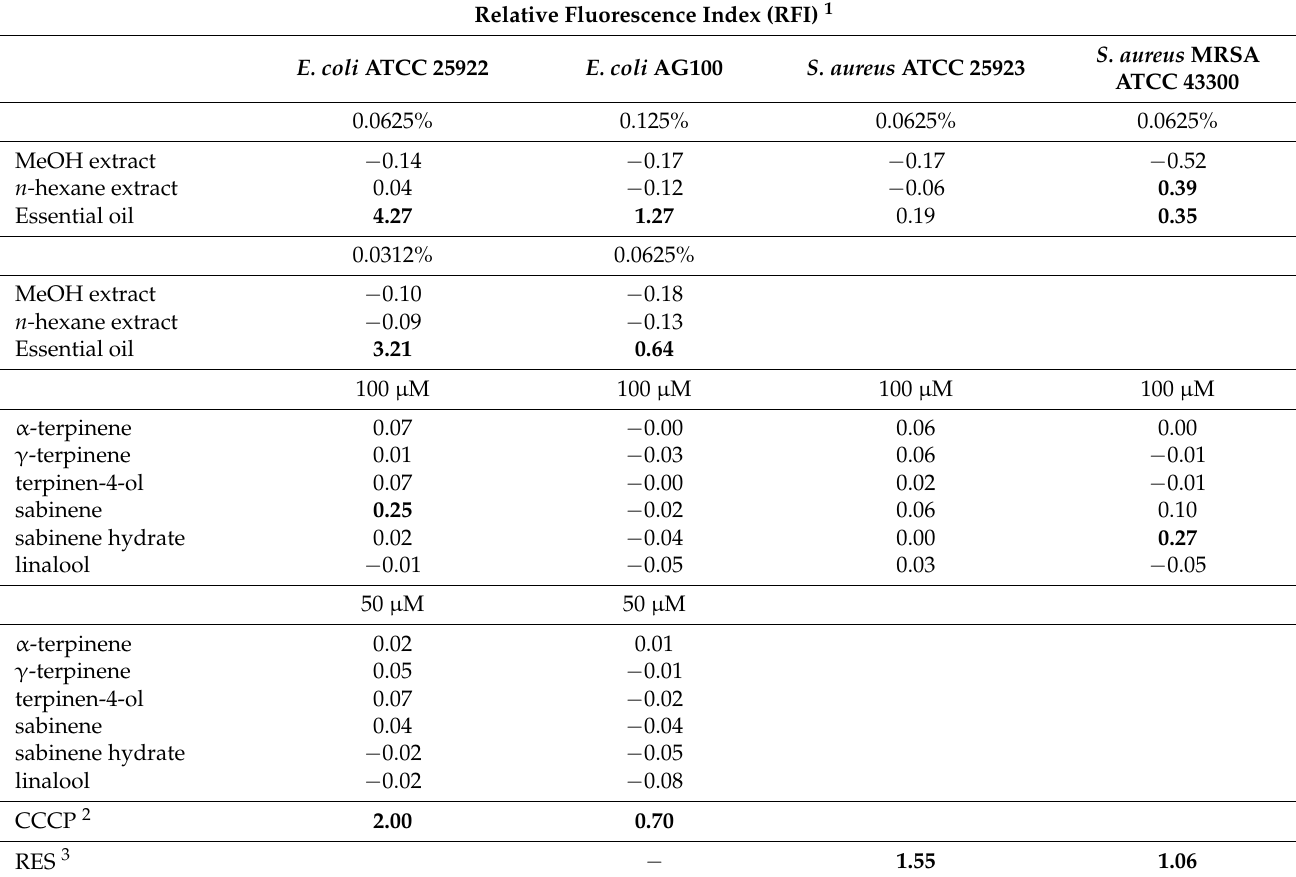
Table 5. Relative fluorescence index (RFI) of tested extracts, essential oil and its constituents against E. coli ATCC 25922, E. coli AG100, S. aureus ATCC 25923 and S. aureus MRSA ATCC 43300. Relative Fluorescence Index (RFI)